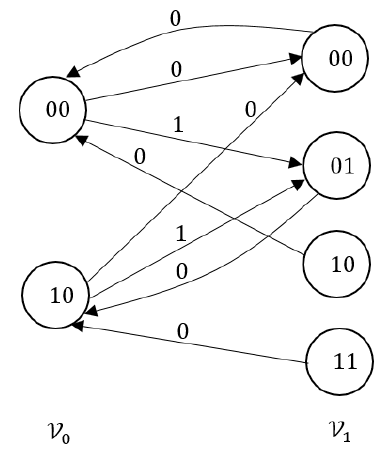
Figure 1. Moision–Siegel representation of ( Σ , σ )